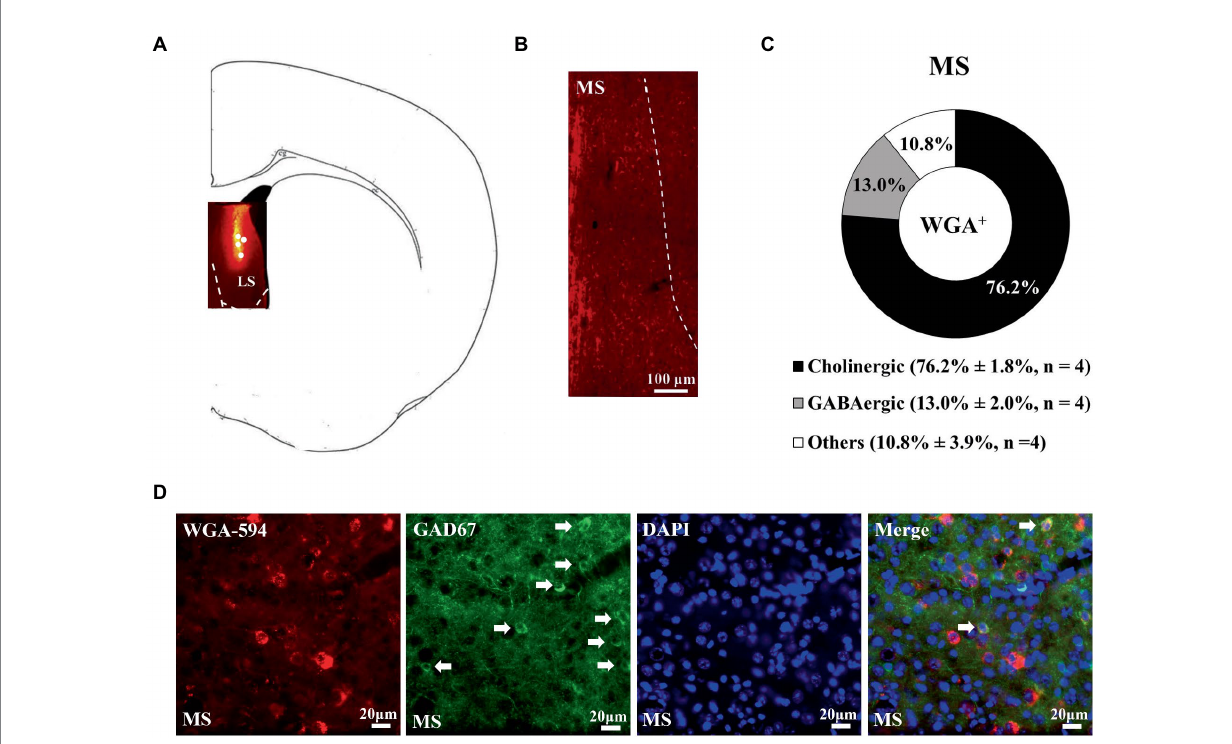
FIGURE 2 Unilateral dorsal lateral septal WGA-AF594 infusion was retrograde traced to GABAergic neurons in ipsilateral dorsal lateral septum. (A) Schematics of lateral septum and representative WGA-AF594 infusion (red) site in dorsal lateral septum. Solid white circles represent injection site. (B) Representative photomicrograph showing WGA-positive (red) spots in medial septum (MS). (C) Pie diagram for cholinergic, GABAergic and other neurons of WGA- positive spots in medial septum. Mean ± SEM is shown. (D) Representative photomicrographs of WGA + (red), GAD67 + (green), DAPI + (blue), and (WGA/ GAD67/DAPI) + (indigo center, yellow surround) neurons in medial septum. White arrows annotate positive cells. Scale bar = 20 μ